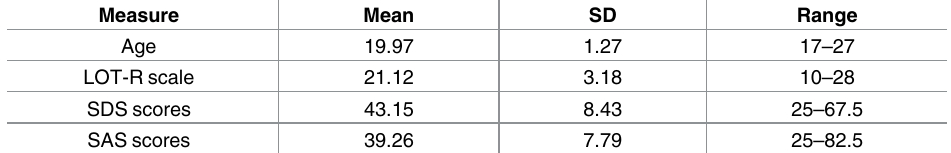
Table 1. The mean, range and the standard deviation of age, LOT-R scores, SDS and SAS scores of the participants (N = 330; male = 144).